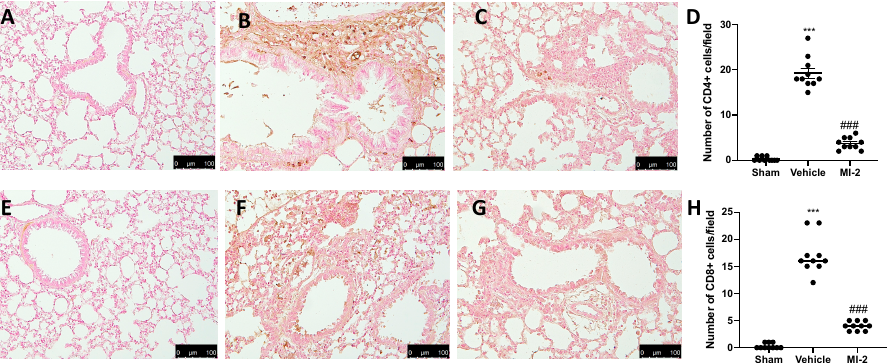
Figure 3. Effect of MI-2 on CD4 and CD8 expression: Immunohistochemical analysis of CD4: sham ( A ), vehicle ( B ), MI-2 ( C ), number of positive cells/field ( D ), immunohistochemical analysis of CD8: sham ( E ), vehicle ( F ), MI-2 ( G ), number of positive cells/field ( H ). For each analysis, n = 10 animals from each group were employed.